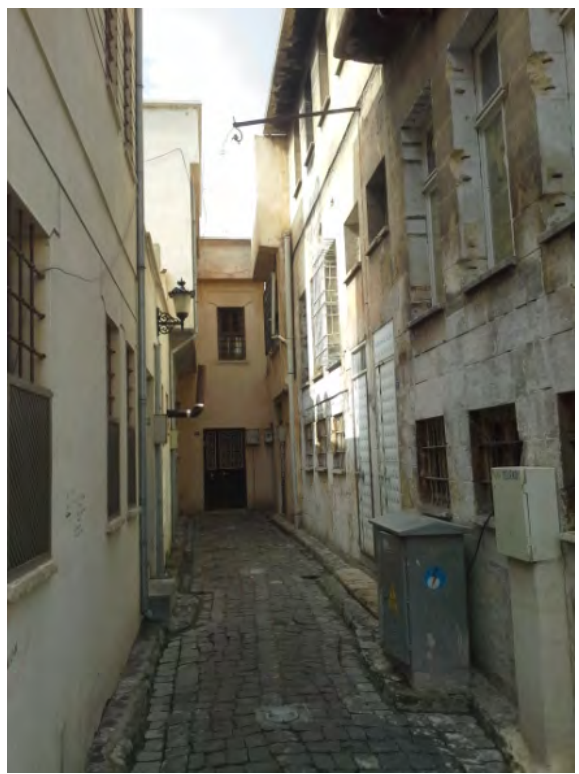
Figure 7. A Dead End Street in Bey neighborhood (Tas¸tan,